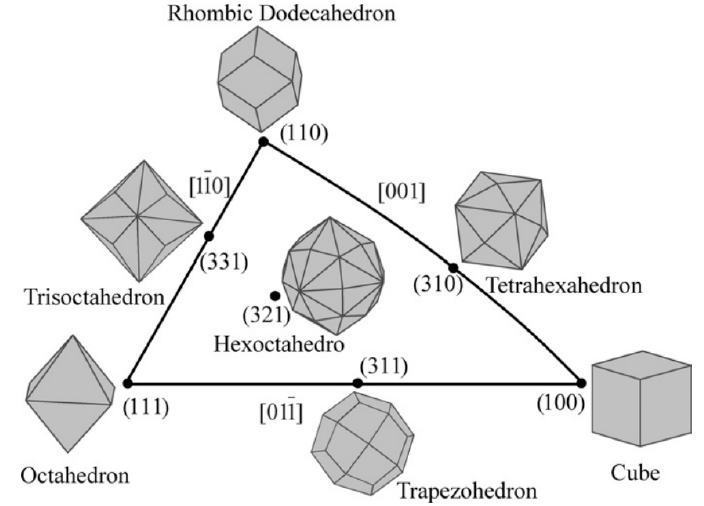
Figure 2. Unit stereographic triangle of polyhedral nanocrystals bounded by different crystal planes. Reproduced with permission from reference